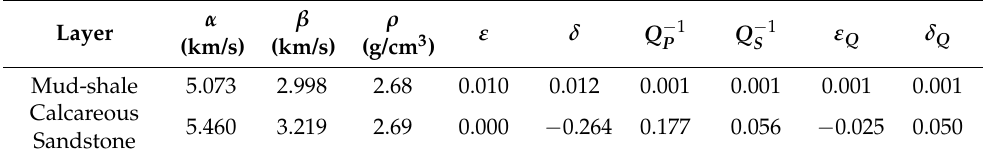
Table 2. The parameters of attenuated anisotropic model